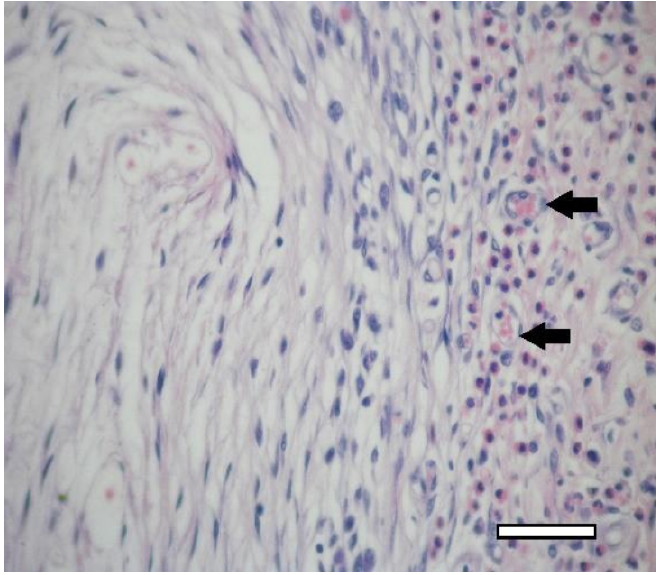
Figure 16. 2nd group (MSC only), 2 weeks. Eosinophilic infiltrate (arrows) in the connective tissue capsule. Staining with hematoxylin and eosin, objective lens × 40, scale bar—50 µ